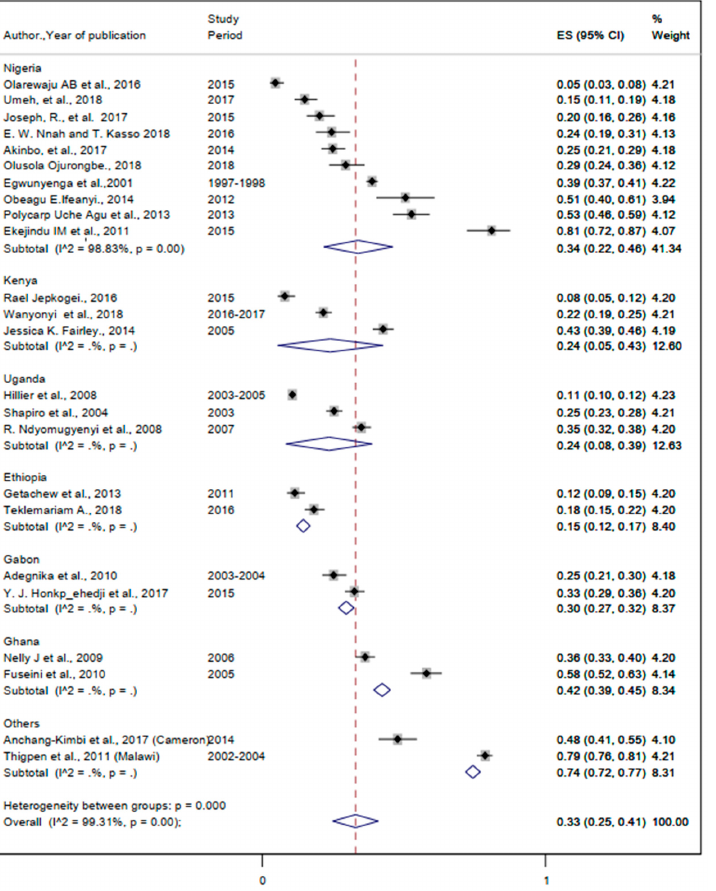
Figure 3. Forest plot for the overall and country—specific pooled prevalence of malaria among pregnant women in sub—Saharan Africa.